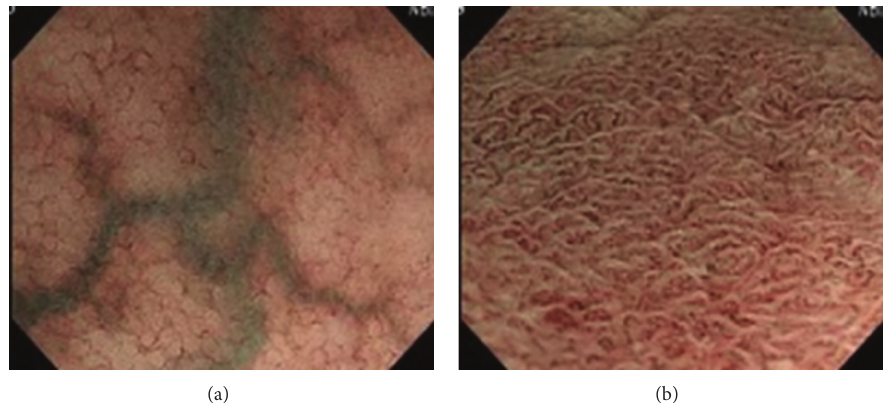
Figure 2: Narrow band imaging- (NBI-) guided magnifying endoscopic findings of microvascular pattern (MVP) were divided into either MVP regularly arranged in a honeycomb-like structure (MVP-regular (a)) or MVP with irregular, tortuous structure (MVP-irregular